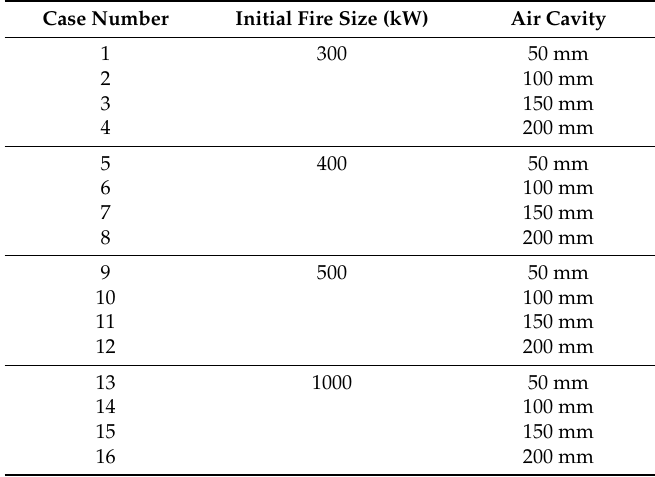
Figure 5. Computation domain of the exterior cladding system. Figure 5 . Computation domain of the exterior cladding system. Table 1. Numerical simulation cases and configurations for fire size and air